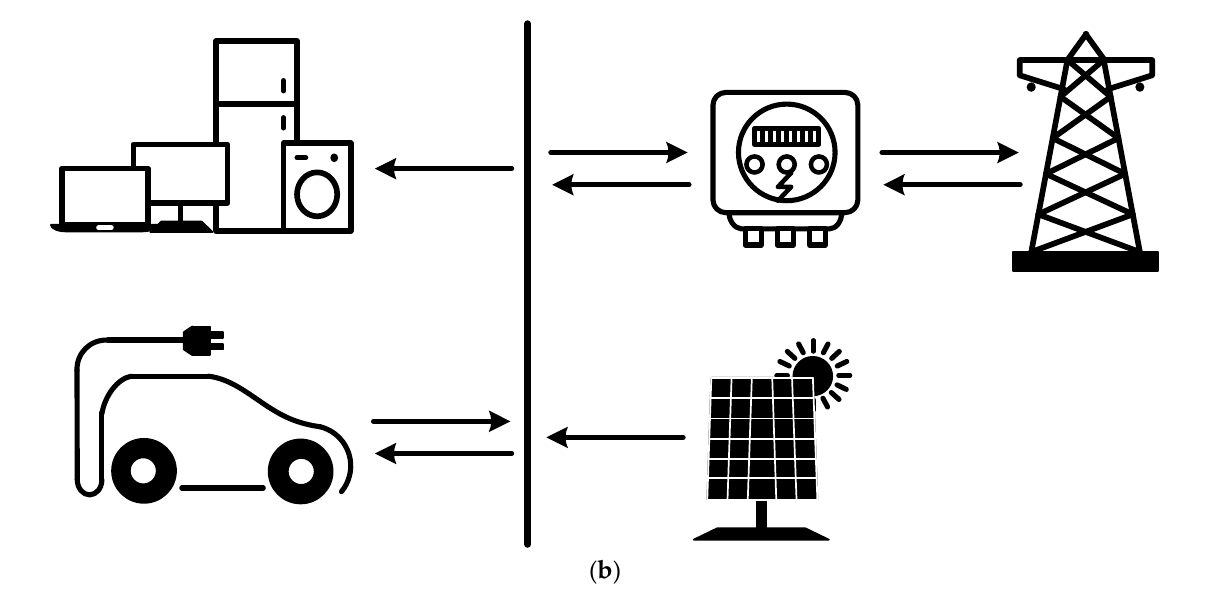
Figure 1. V2Hs as the future for spreading small-scale PV prosumers; ( a ) classical structure with batteries, ( b ) planned structure using batteries of the EVs ( V2H ).